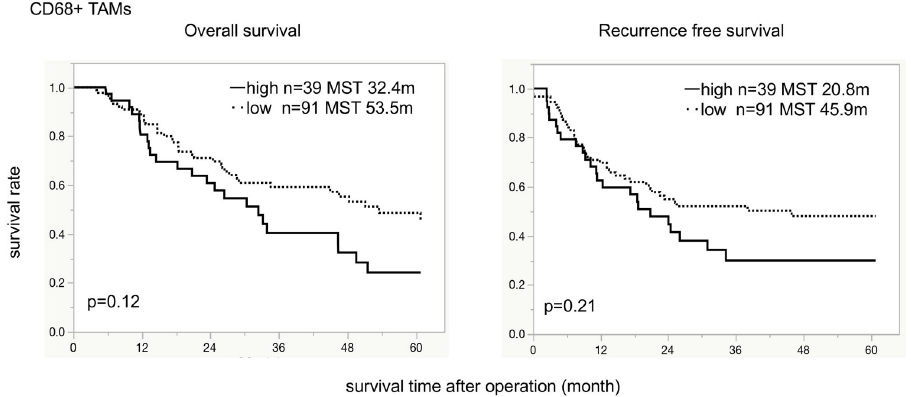
Fig 3. Overall survival and recurrence-free survival for tumor-associated macrophages. Kaplan-Meier survival curve indicates that there is no significant difference in OS and RFS between the high- and the low-infiltrating CD68 + TAMs groups. TAMs: tumor-associated macrophages, OS: overall survival, RFS: recurrence-free survival, MST: median survival time.